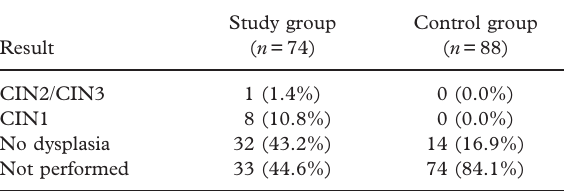
Table I. Participants’ cervical biopsy results. The data are presented as number (percentage). The differences between the groups are statistically significant (chi square 30.7, p 5 0.001).